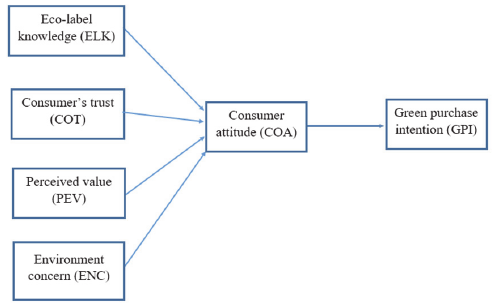
Fig 1. Analytical